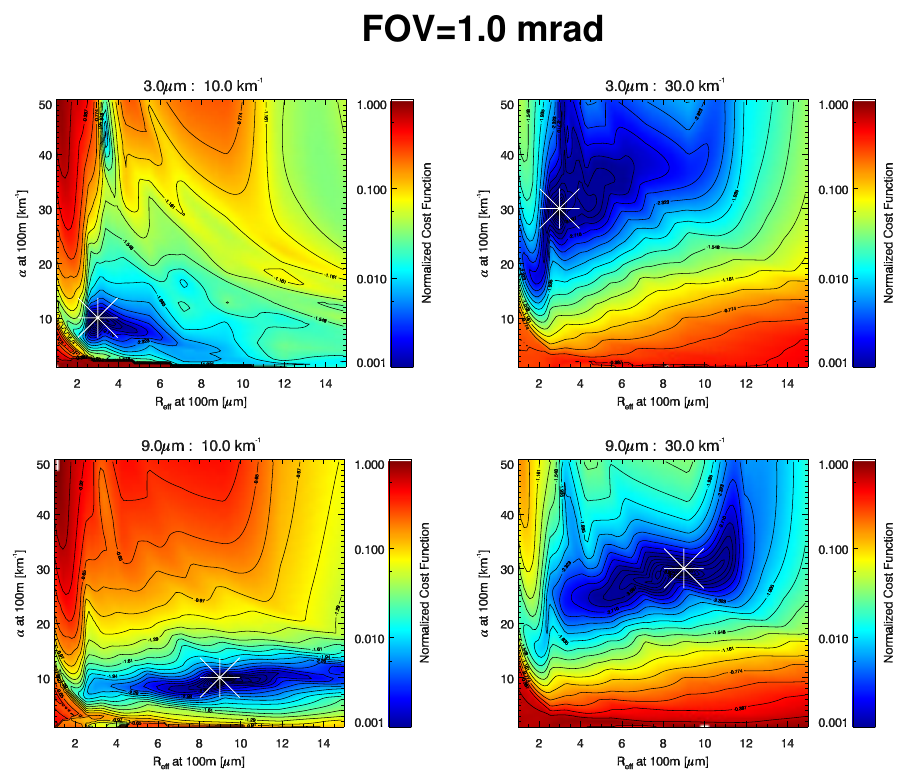
Figure 5. Normalised results from the application of Eq. (20) for a lidar wavelength of 355nm as a function of α 100 ,k and R eff,100,k for two true values of α 100 and R eff,100 (as indicated) for a lidar FOV of 1.0mrad and a cloud base of 1km. The symbol is used to mark the location of the minimum of the cost